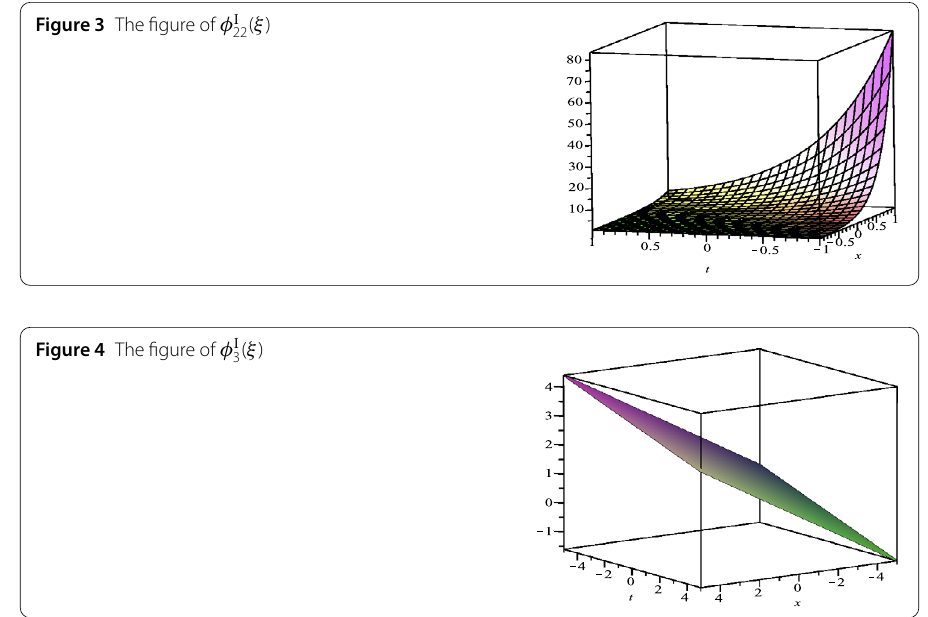
Figure 3 The figure of φ I 22 ( ξ )